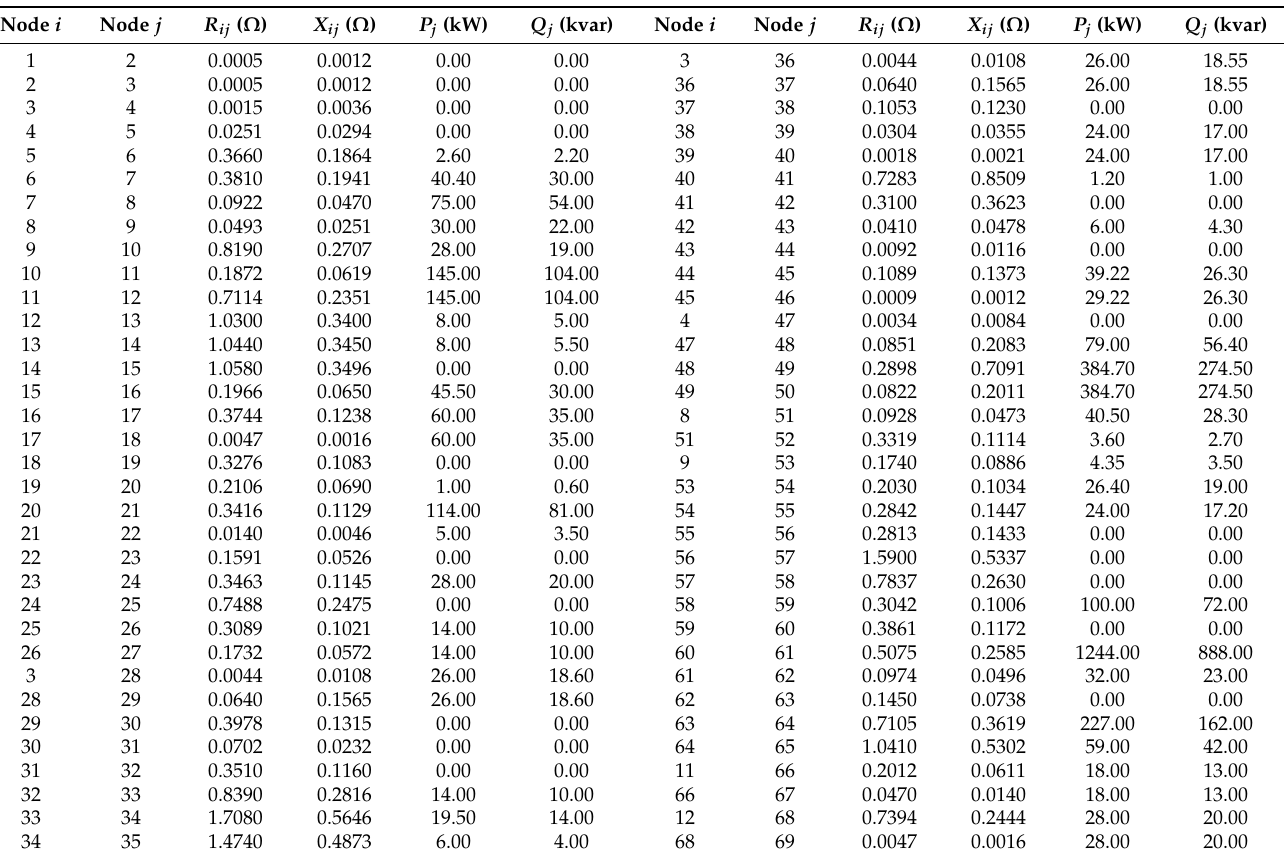
Table 6. Parameters of the 69-node test system.